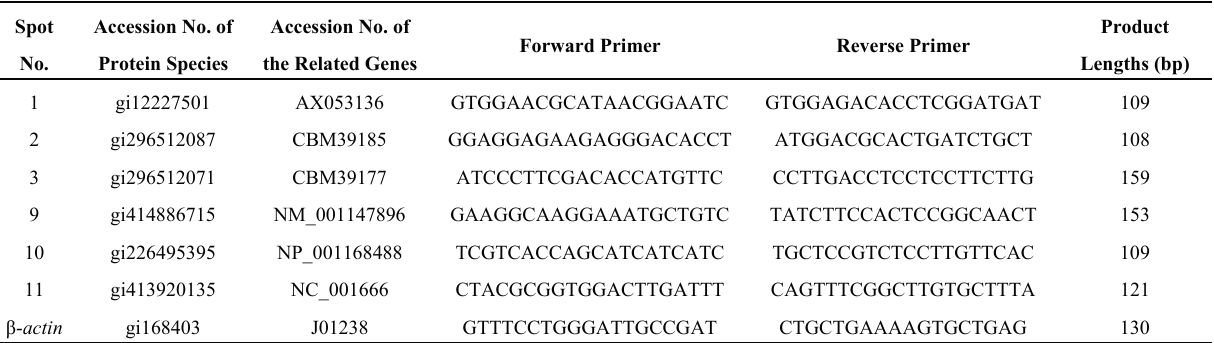
Table 2. Primer sequences used in quantitative real-time polymerase chain